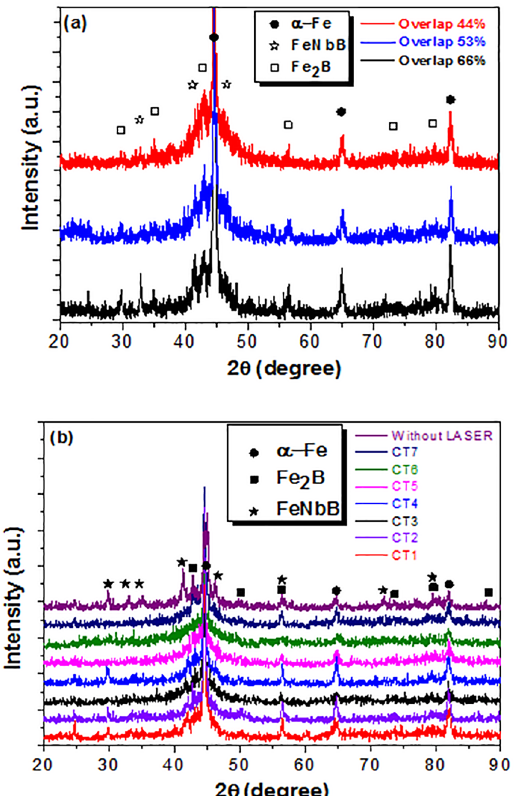
Cr Nb B (at%) coatings 60 8 8 24